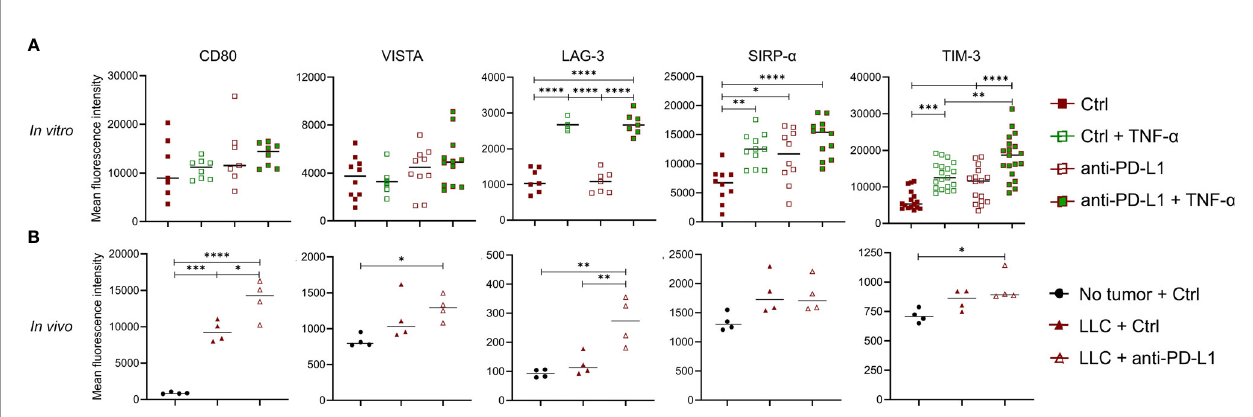
FIGURE 5 | Anti-PD-L1 therapy upregulates checkpoints on monocytes. (A) Bone marrow-derived monocytes were plated with LLC cells and treated with 5 μg/ml Ctrl or anti-PD-L1 mAb, with or without 10 ng/ml TNF- a . Three days later, mean fl uorescence intensities were obtained via fl ow cytometry for CD80, VISTA, LAG-3, SIRP- a and TIM-3 (n=3, 4 technical replicates). (B) Three weeks after LLC engraftment, lungs from anti-PD-L1 or Ctrl mAb-treated mice were isolated to enrich the Ly6C + monocytes and evaluate their expression of the same checkpoints as described in panel (A) As internal reference, monocytes derived from healthy mice were taken along. A two-way panel (A) or one-way panel (B) ANOVA with Tukey ’ s multiple comparisons test was performed to determine statistical signi fi cance. * for p < 0.05; ** for p < 0.01; *** for p < 0.001; and **** for p <